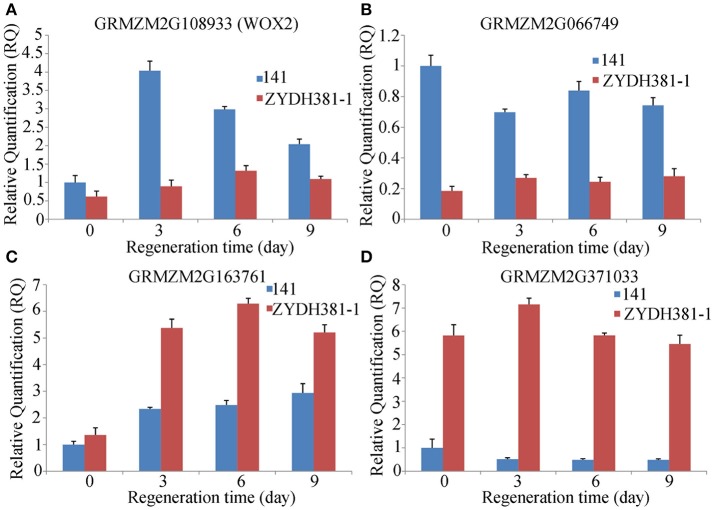
Expression levels of candidate genes at different regeneration stages. Here, 141 is a line with high regeneration and ZYDH381-1 IS the one with low regeneration. (A–D) Represents the relative expression levels of GRMZM2G108933 (WOX2), GRMZM2G066749, GRMZM2G163761 and GRMZM2G371033, respectively.